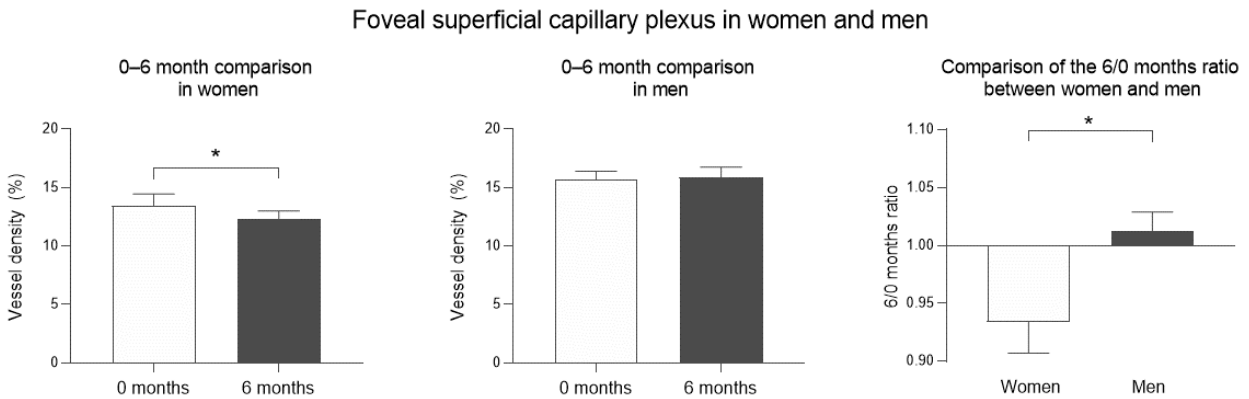
Figure 2. Optical coherence tomography angiography (OCTA) analysis in men and women. Superficial capillary plexus (SCP) analysis. Mean vessel density (%) of the foveal and parafoveal regions. Error bars correspond to the SEM. * p < 0.05 .